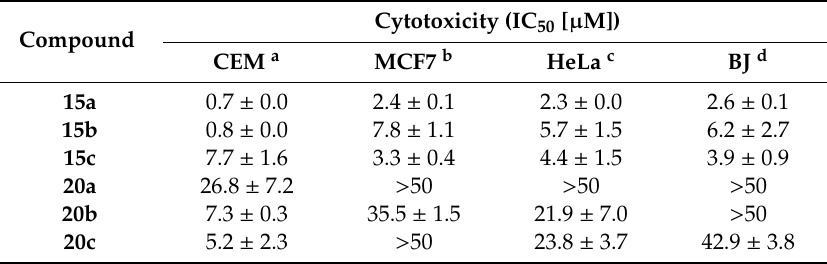
Table 1. Experimental cytotoxicity data found for 15a – 15c and 20a – 20c